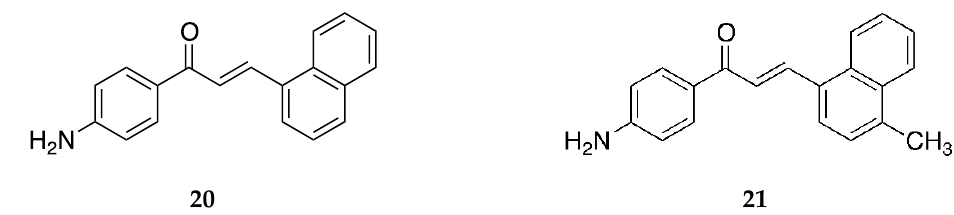
Figure 17. Chemical structures of 4-aminochalcone derivates with a naphthalene ring.